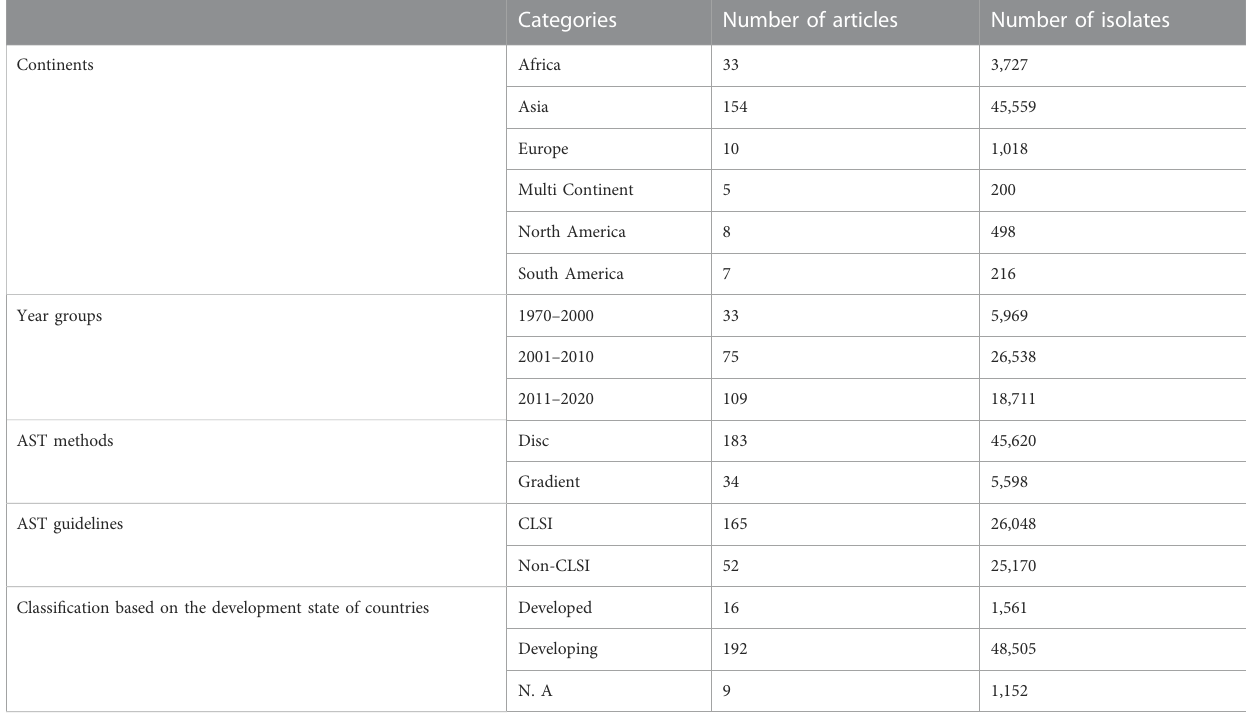
TABLE 1 Descriptive statistics of included